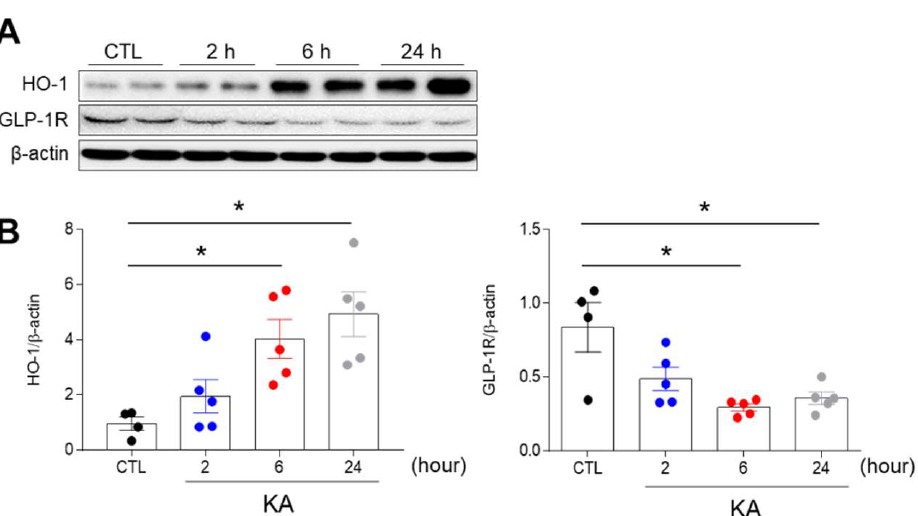
Figure 1. Effects of KA treatment on hippocampal HO-1 and GLP-1R expressions in KA-treated mice. ( A ) Western blot analysis of hippocampal HO-1 and GLP-1R protein expressions in mice at 2, 6, and 24 h after KA treatment. ( B ) Quantitative expressions of HO-1 and GLP-1R protein from Western blot analysis ( n = 4–5 mice per group). Densitometric values for HO-1 and GLP-1R were normalized to β –actin levels. Data are presented as mean ± standard error of the mean (SEM). * p < 0.05 vs. control (CTL). The one-way analysis of variance (ANOVA) was used to detect any statistically significant differences time-dependently ( B ). HO-1/ β –actin; p values = 0.0273 (6 h), 0.0044 (24 h), F (3, 15) = 7.478, GLP-1R/ β –actin; p values = 0.0026 (6 h), 0.0071 (24 h), F (3, 15) = 7.446.